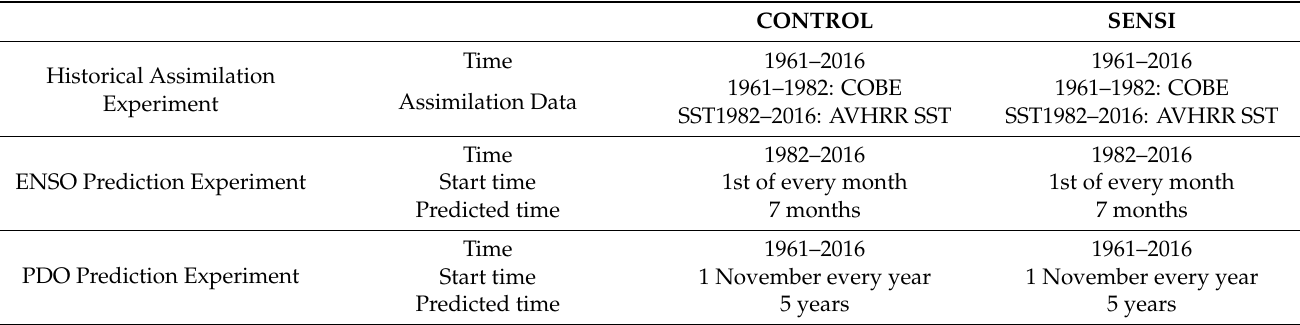
Table 1. Experimental